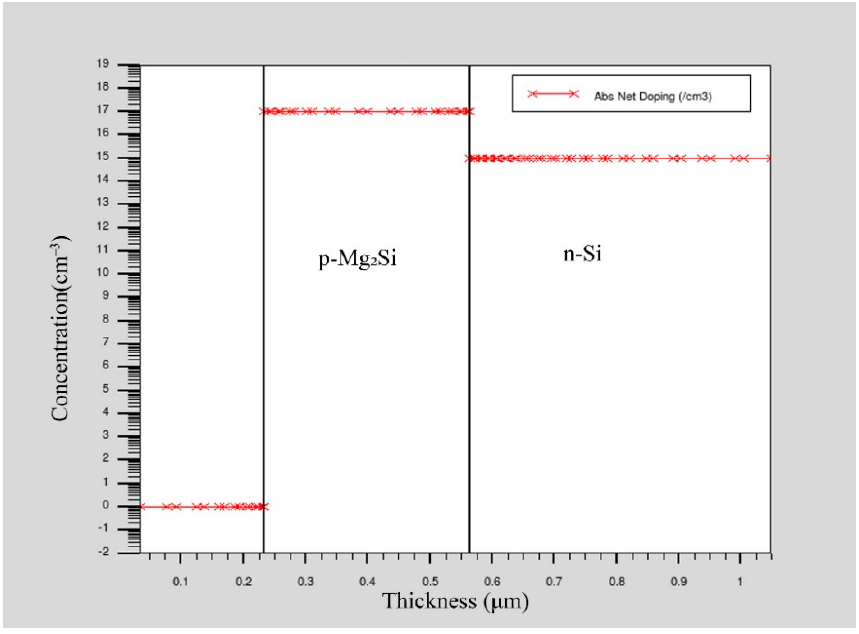
Figure 3. The concentration distribution of Mg 2 Si/Si heterojunction PD. Table 1. The optical and electrical material parameters for Mg 2 Si and Si.